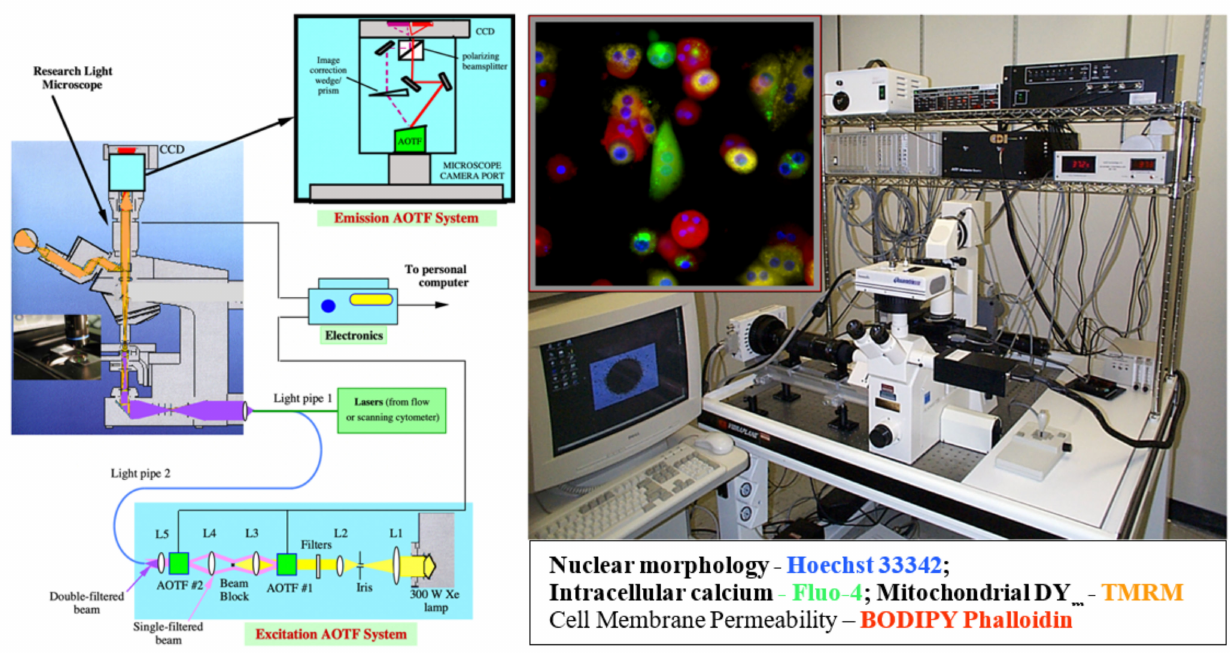
Figure 10. Two-AOTF microscopy workstation: schematics ( left ) shown in a laboratory ( right ). Multimode microscopy- based multiparameter fluorescence cellular studies of drug candidates, in collaboration with Pfizer and JPL (see text for details). The upright microscope in the schematics ( left ) was replaced with an inverted microscope (see image on the